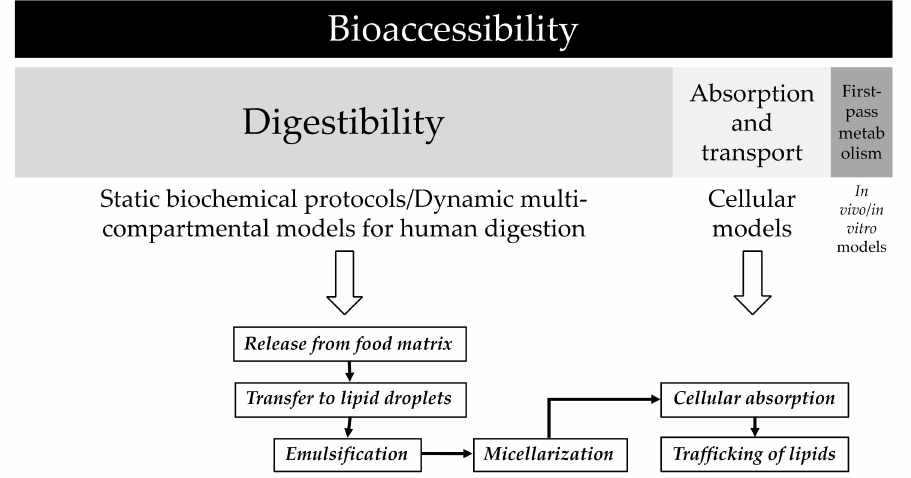
Figure 1. The di ff erent contribution of the three sequential steps that yield the bioaccessibility value of carotenoids, including the in vitro models required to measure their e ffi ciency, showing the main molecular events associated to each